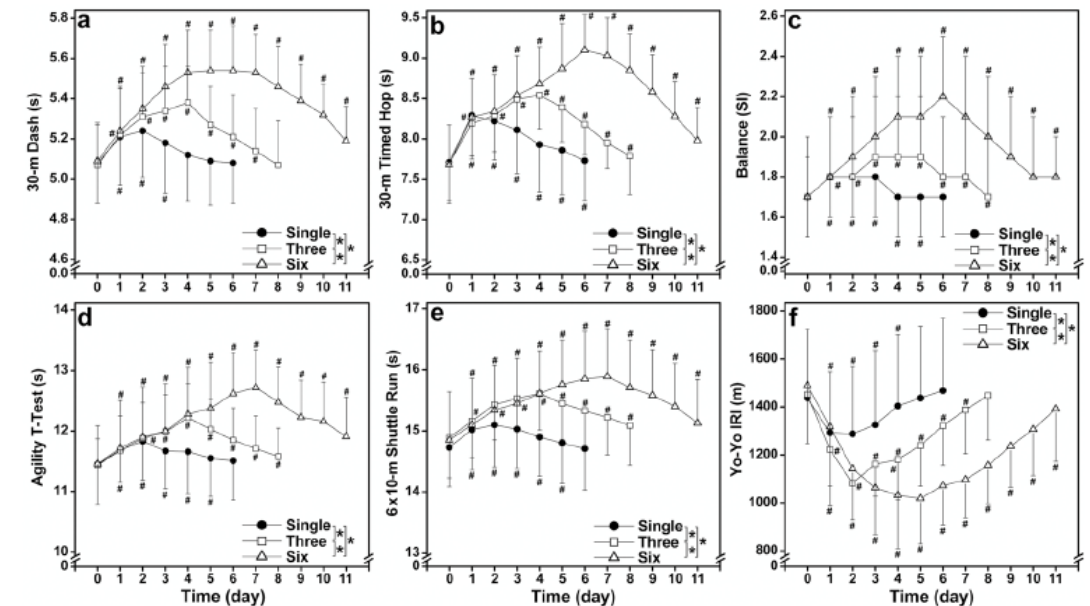
Figure 4. Changes (mean ± SD) in 30-m dash ( a ), 30-m timed hop test ( b ), balance with eyes closed on unstable surface (Balance, ( c )), agility t -test ( d ), 6 × 10-m shuttle run ( e ), and Yo-Yo Intermittent Recovery Test level 1 (Yo-Yo IR1; ( f )) at baseline (0), 1 h after the Loughborough Intermittent Shuttle Test (LIST) (Day 1), and 1, 2, 3, 4 and 5 d (Day 2–6) after the LIST (Single), before the 1st LIST (0), 1 h after each LIST performed 3 d in a row (Day 1–3) and 1, 2, 3, 4 and 5 d (Day 4–8) after the 3rd LIST (Three), and before the 1st LIST (0), 1 h after each LIST performed 6 d in a row (Day 1–6) and 1, 2, 3, 4 and 5 d (Day 7–11) after the 6th LIST (Six). * indicates a significant ( p < 0.05) difference between groups based on the interaction effect shown by the ANOVA. # indicates a significant ( p < 0.05) difference from the baseline value.